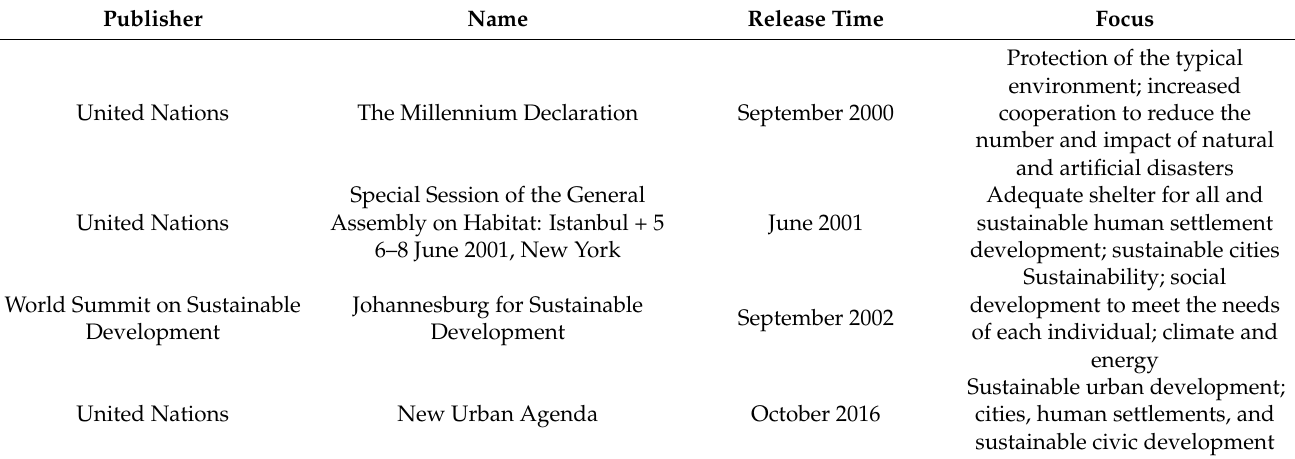
Table 1. High-density city-related initiatives.